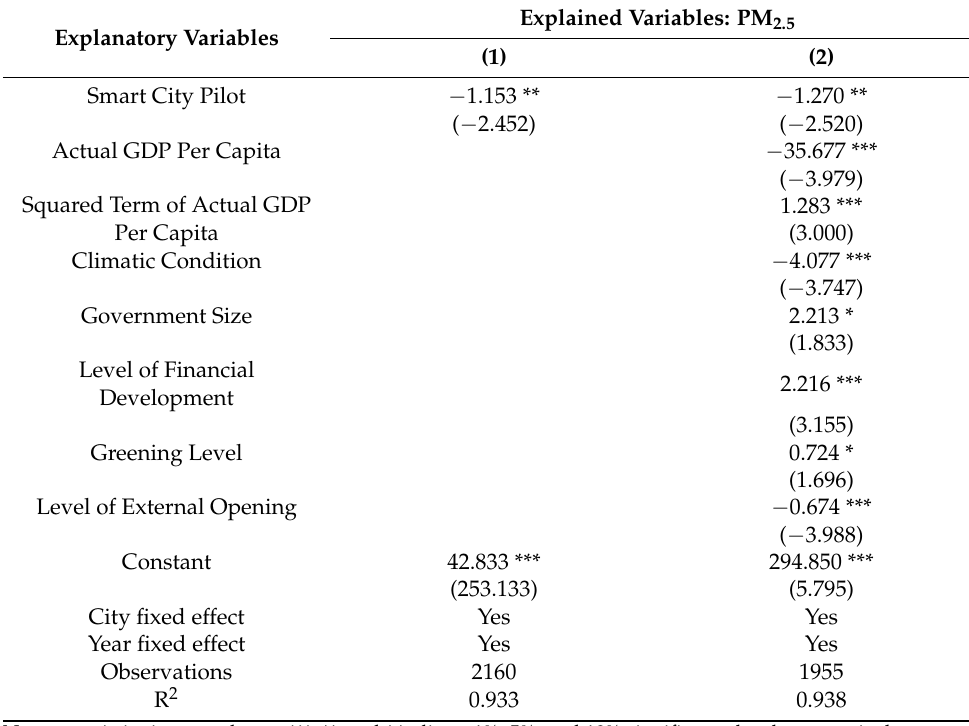
Table 2. Basic estimation